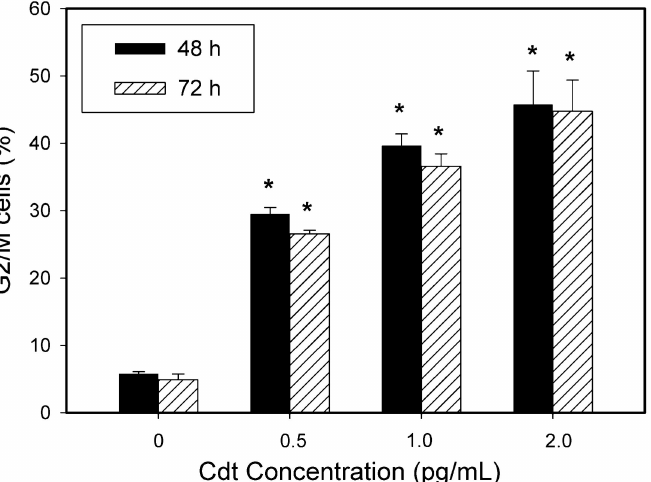
Figure 2. Cdt-induced accumulation of G2/M cells persists for 72 h. TIGK cells were treated with varying amounts of Cdt for 48 (solid bars) and 72 h (hatched bars). The percentage (mean ± SEM) of G2/M cells is plotted versus toxin concentration; * indicates statistical significance ( p < 0.05) when compared to untreated